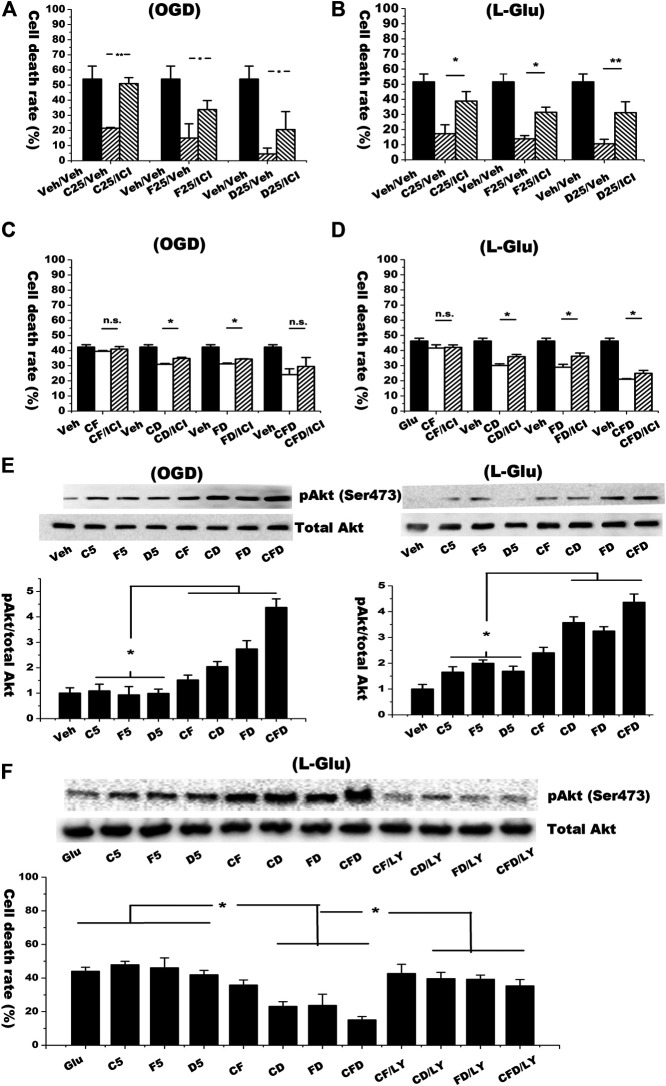
Combined isoflavones groups synergistically induced Akt phosphorylation and inhibited cell death against OGD/RO and l-glutamate-induced cell death via ER-PI3K-Akt pathway. (A,B) Primary cultured nature neurons (DIV10) were incubated with 1 μM of ER antagonist ICI182780 for 15 min before exposed to OGD/RO (4 h OGD plus 20 h RO) or l-glutamate (8 mM l-glutamate for 6 h) challenge and treated with 25 μM isoflavones treatment. Rate of cell death was determined by LDH release assay. (C,D) ER antagonist was added to the groups of combined isoflavones (total concentration 5 μM). (E) Western blot results in the expression of p-Akt and Akt. (F) Cells were pre-treated with 10 μM LY-294002 15 min before isoflavones treatment in l-glutamate challenging model. Cell lysate was collected for the Western analysis to detect the pAkt, whereas cell medium was used to determine the rate of cell death with LDH release assay. “Veh” represents vehicle control that receives same volume of dissolvent. Data were represented as mean ± SD, n = 3, *
p < 0.05, n. s.: not significant.